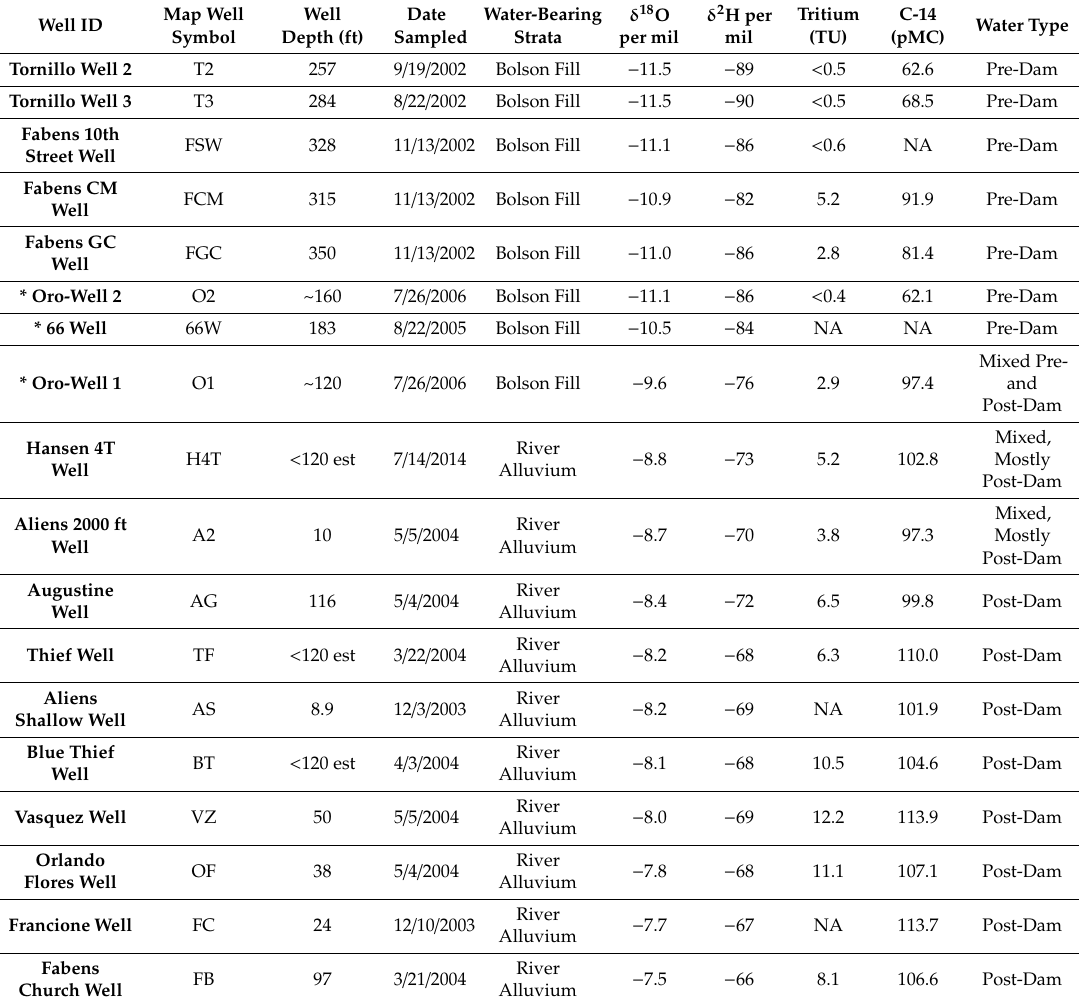
Table 2. Information on water wells sampled in the study area, including map well index, environmental isotope data, and water type identified as pre-dam, post-dam, or mixed pre- and post-dam (Figure 3 shows well